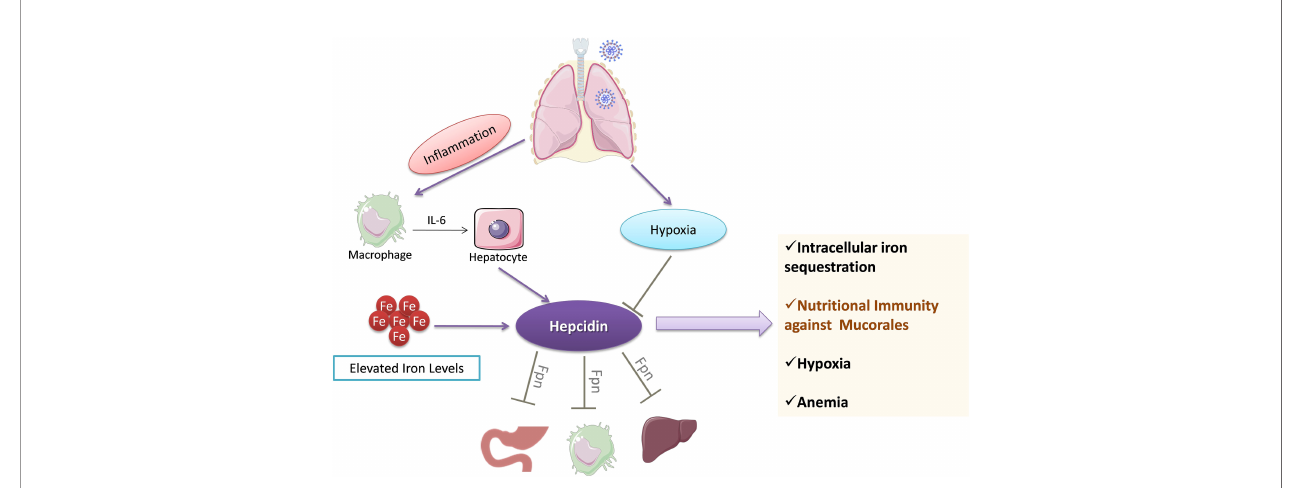
FIGURE 5 | Regulation of iron stores by hepcidin during COVID-19. Hepcidin levels are increased following IL-6-mediated action on hepatocytes. Hepcidin sequesters iron levels inside the cells by downregulating ferroportin (Fpn). The decrease in iron levels leads to anemia and ultimately culminates in hypoxemia. Hepcidin-mediated decrease in iron levels may provide protection against pathogens such as mucorales fungi. IL-6, Interleukin-6; Fpn,